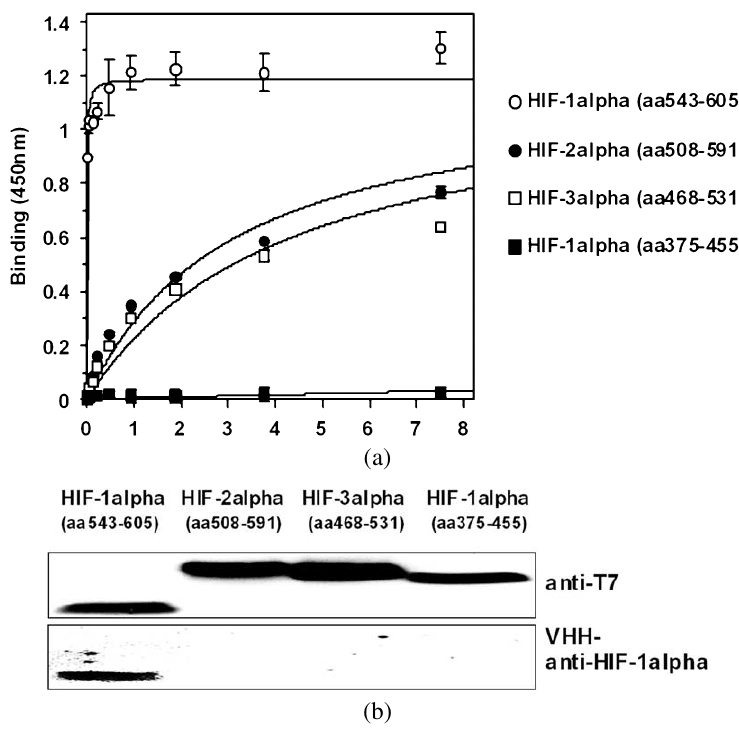
Fig. 2. VHH-AG2 binds specifically to HIF-1 α . (a) Binding of bivalent AG-1N2C-MYC to immobilized recombinant HIF-1 α fragment C (aa543-605), HIF-2 α (aa508-591), HIF-3 α (aa468-531) and HIF-1 α fragment E (aa375-455). The apparent affinity is approximated from the determined concentration yielding half-maximum binding to HIF-1 α (aa543-605) at B max (OD450 nm) ≈ 1.188. Data represent the mean + SD of three experiments. (b) Western blot analysis on recombinant HIFs with anti-T7 and AG-1N2C-MYC (VHH)